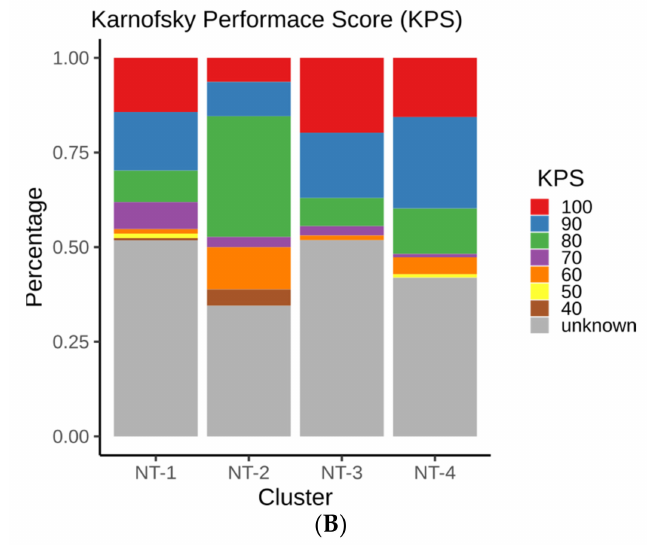
Figure 3. ( A ) Kaplan–Meier survival curves associated with NT-1-4 gliomas. Red, blue, green and purple represent the various NT-1-4 glioma clusters, respectively. Cluster-to-cluster significance was calculated using the log-rank test. ( B ) Karnofsky performance score distribution among NT- 1-4 gliomas. These scores reflect the patient’s ability to perform ordinary tasks and range from 100 (patient without disabilities) to 0 (patient